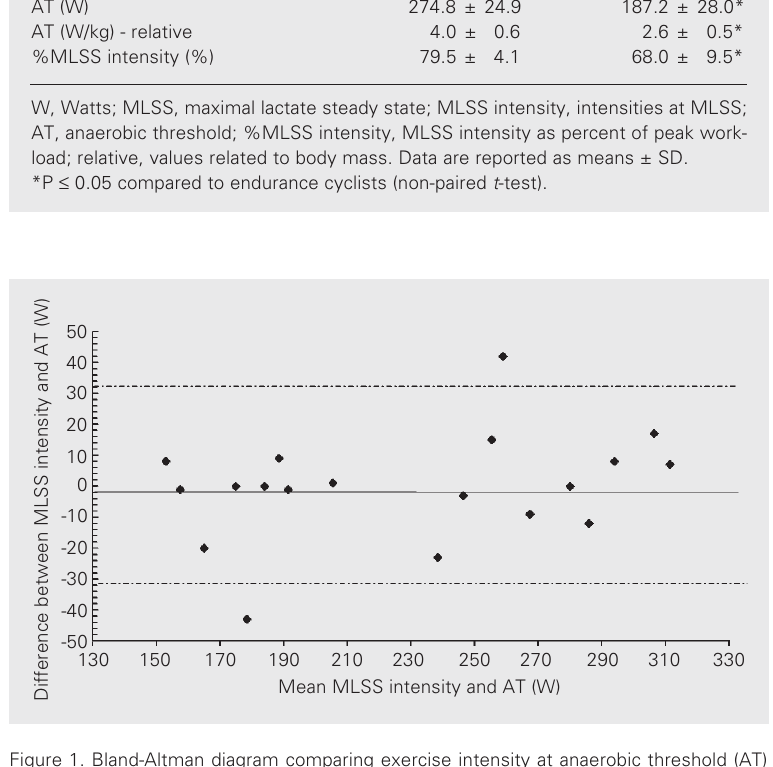
Figure 1. Bland-Altman diagram comparing exercise intensity at anaerobic threshold (AT) and maximal lactate steady state (MLSS intensity) for all subjects (untrained and trained). The solid horizontal line represents the bias between the two measures (i.e., the mean difference between the group means for the two variables). The dashed lines represent the 95% limits of agreement between the two variables, and reflect the extend to which one variable might be expected to differ from another in